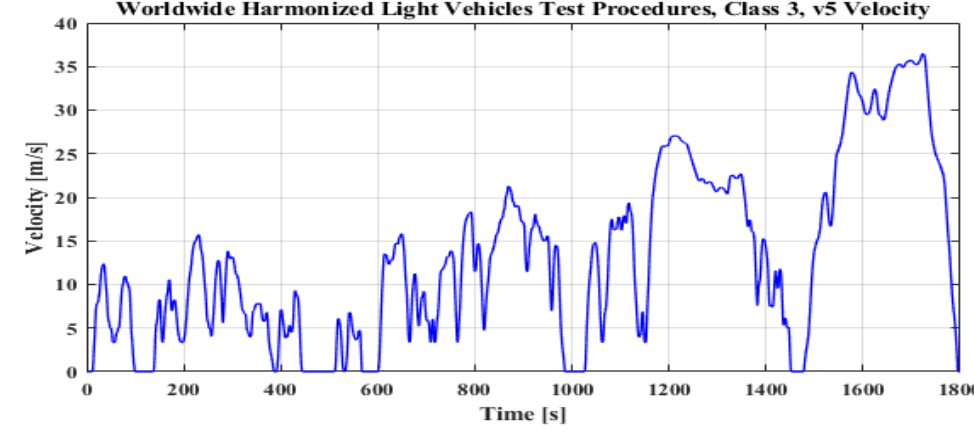
Figure 26. Drive cycle data—WLTC (Class 3).